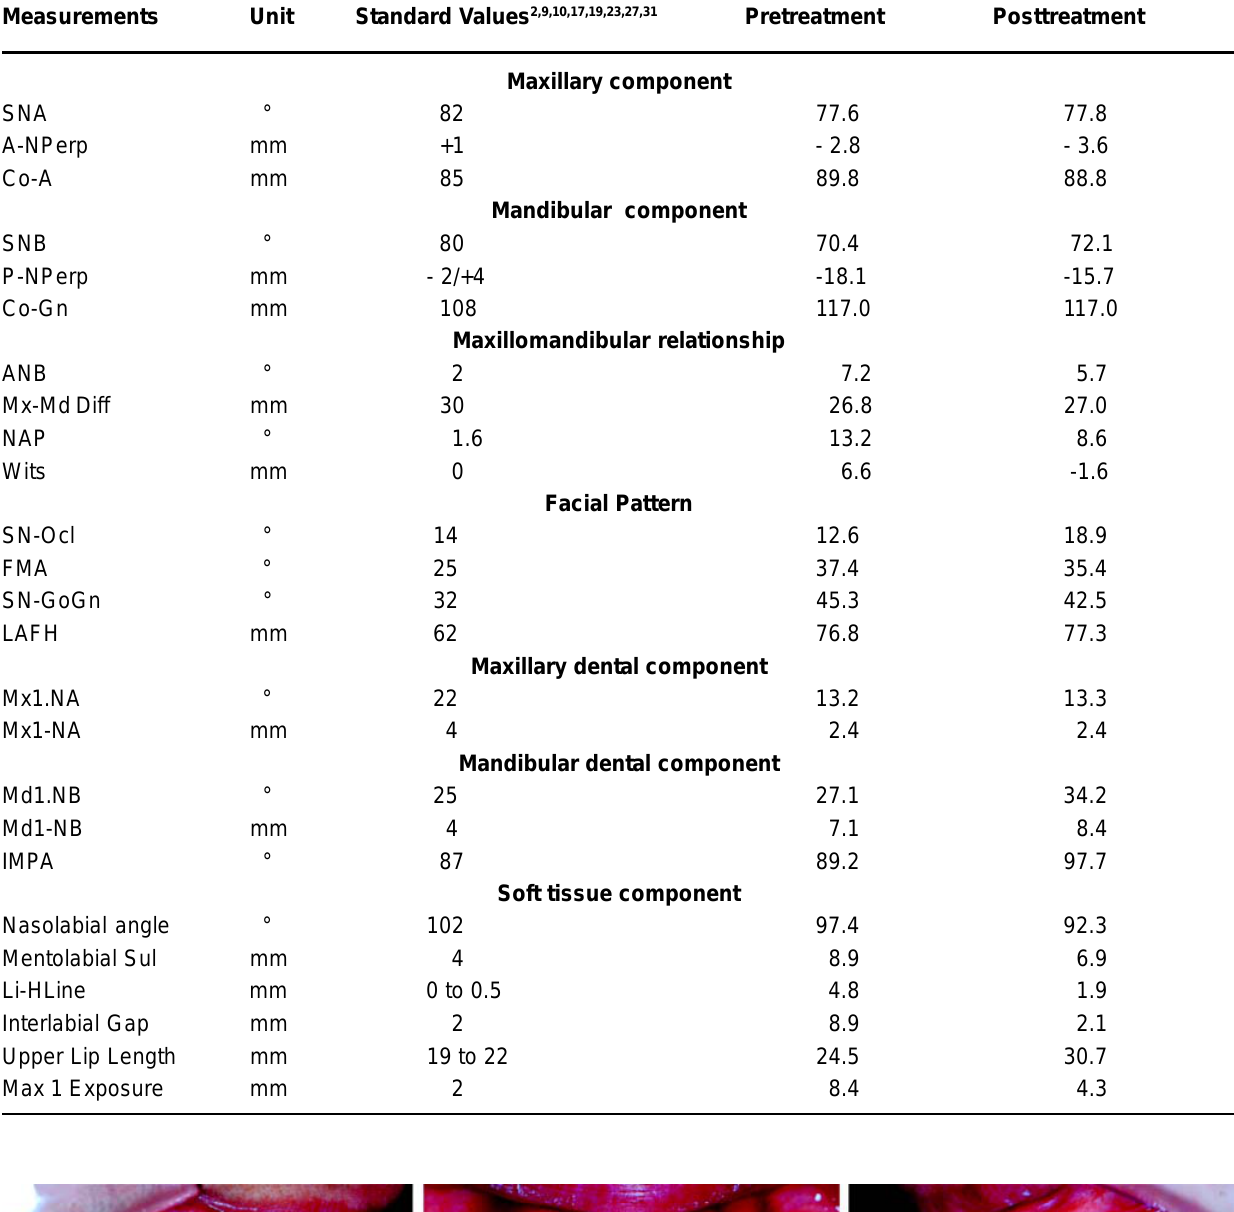
TABLE 2- Cephalometric status at the pretreatment and posttreatment stages